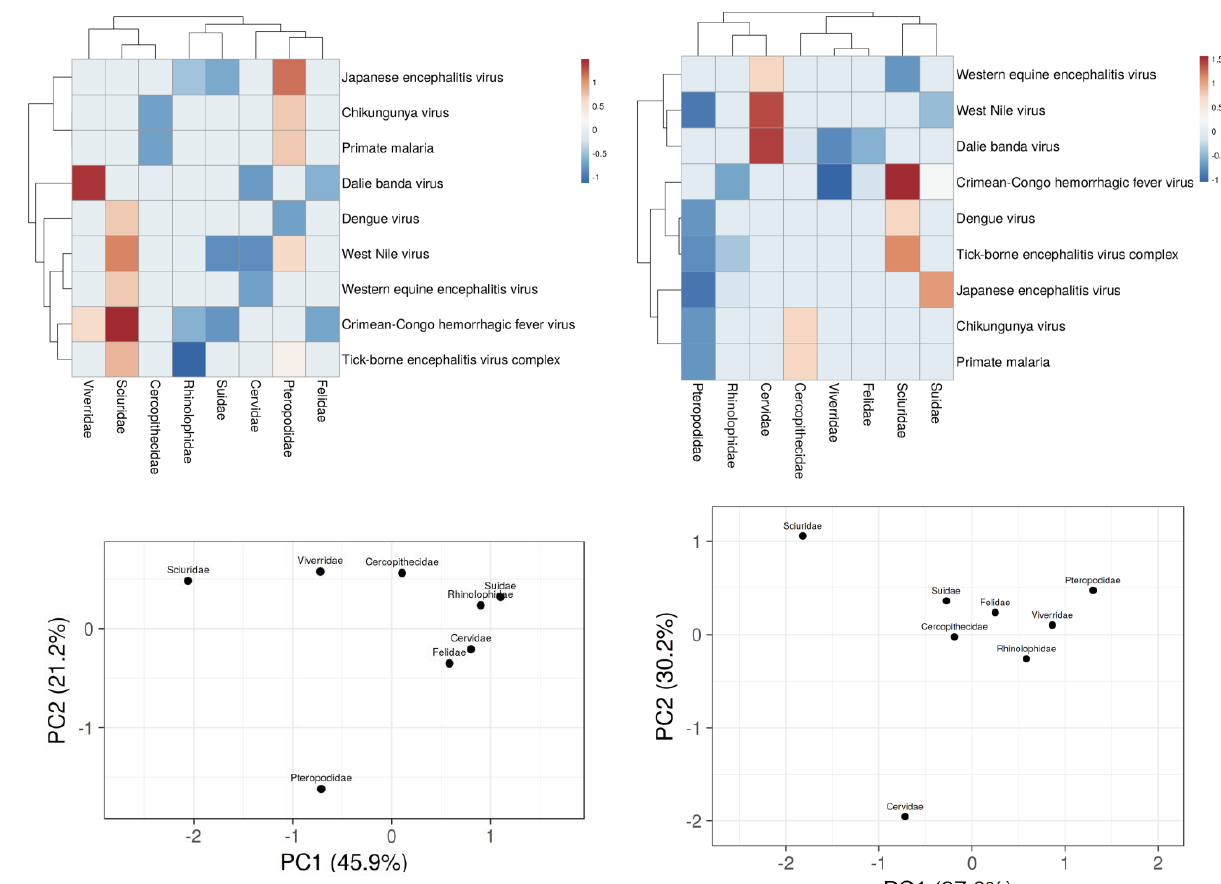
Figure 2. Top: Heatmaps of potential vector borne diseases in various mammal families recorded in wildlife markets in Indonesia ( left ) and Myanmar ( right ). The values are relative with red indicating the highest values and pale blue the lowest. The dendrograms on the left represent the clustering of potential vector-borne diseases whereas the dendrogram on the top indicates the clustering of mammal families. Bottom: Associated principal component plots showing the position of the eight mammal families, with the values between brackets indicating the amount of variation explained by PC1 and PC2, respectively.